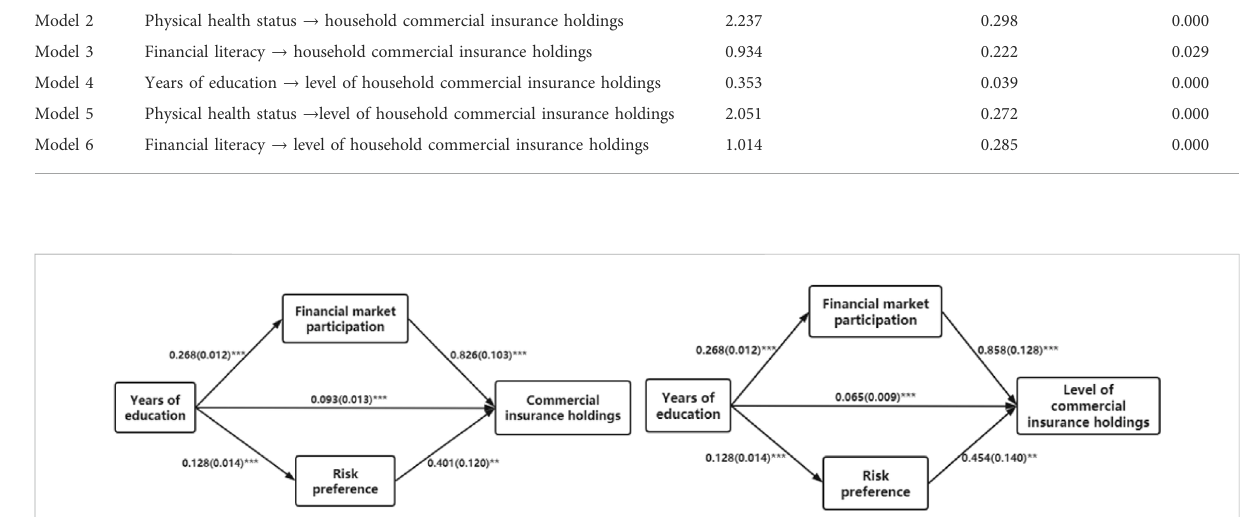
FIGURE 2 Results of the path analysis of years of education and household commercial insurance holding behavior.